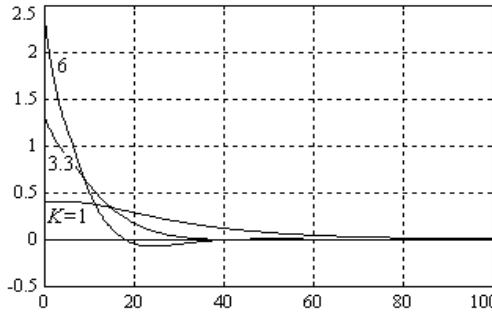
Figure 29. Control responses c ( t ) to a unit step setpoint for K = 1; 3.3; 6.